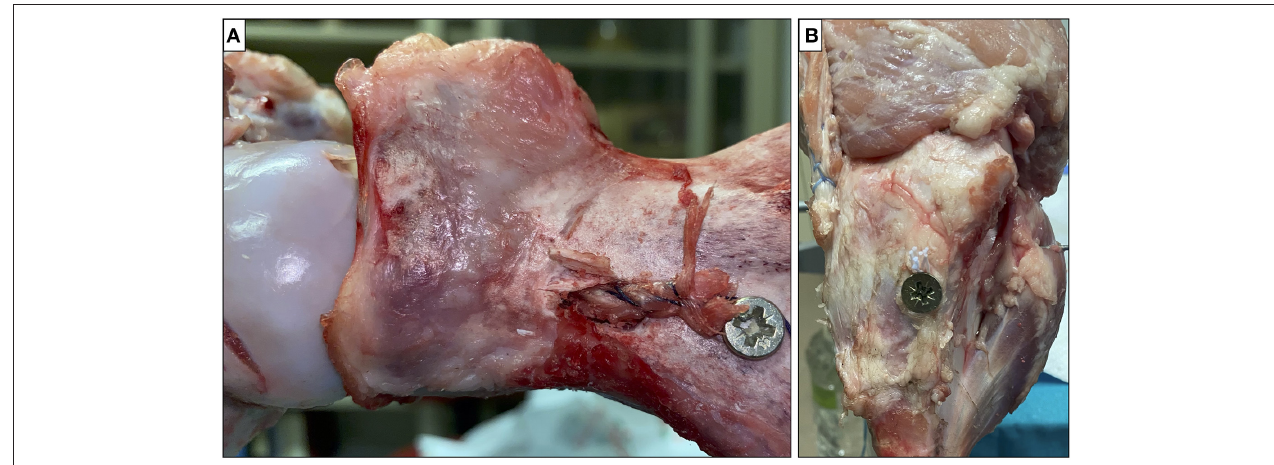
FIGURE 6 | The ligament was fixed at the scapula (A) and humerus (B) with screws.